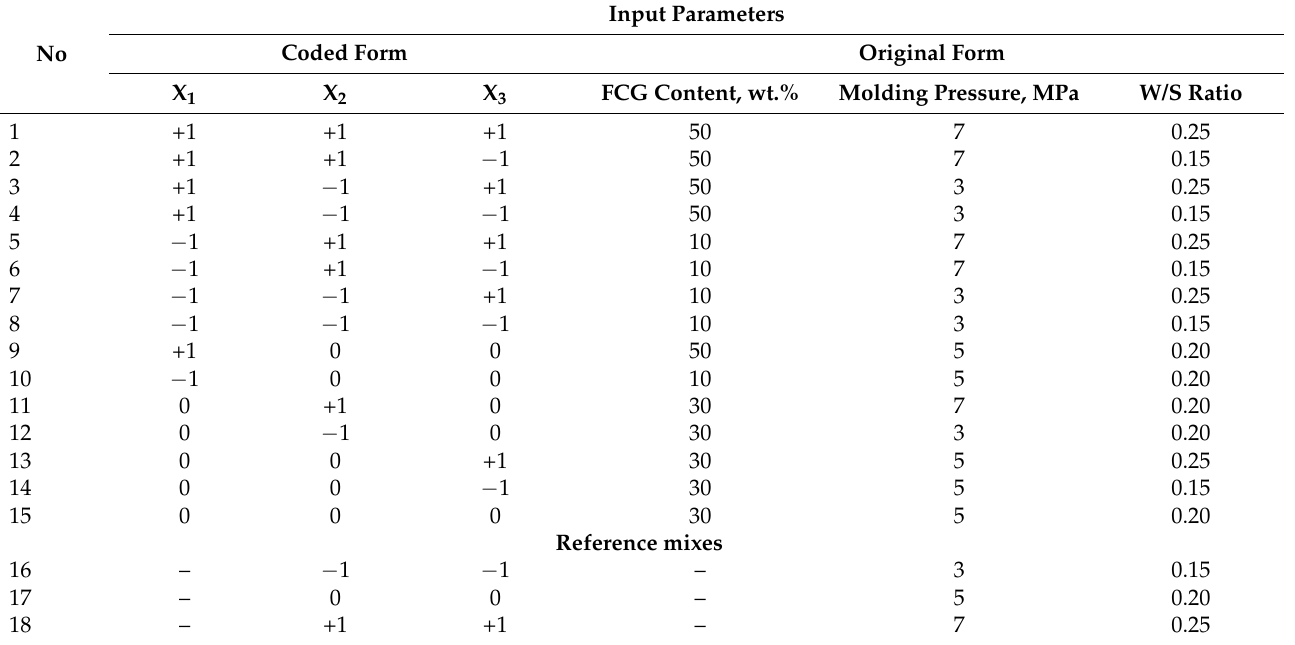
Table 6. Experiment design